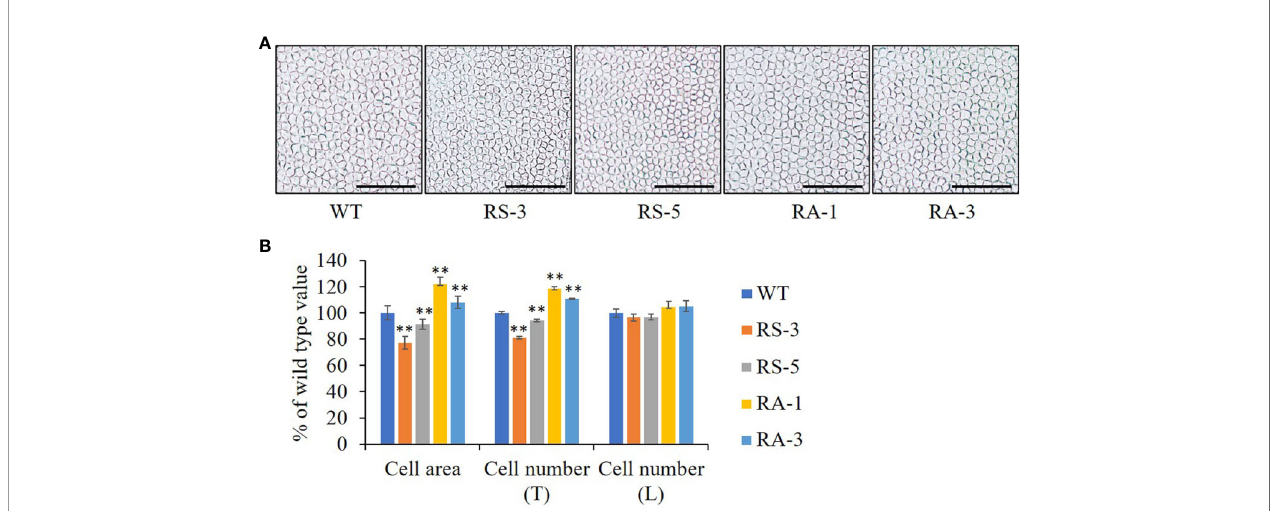
FIGURE 4 | The petal cells size and numbers of different lines. (A) Adaxial petal cells in WT, the RS and RA transgenic lines. (B) Statistical analysis of cell areas and cell numbers along the transverse (T) and longitudinal (T) axis of petals. WT, wild type; RS-3 and RS-5, ZmRLK7 sense transgenic lines; RA-1 and RA-3, ZmRLK7 antisense transgenic lines. Values are means with SD relative to the respective wild-type values. Bars = 100 m m. ** denote signi fi cant differences at p < 0.01 by